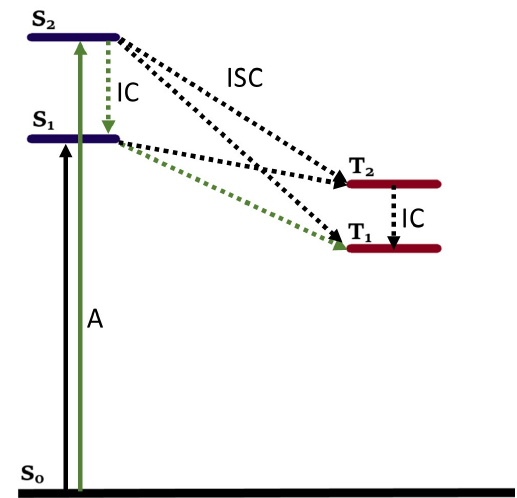
Figure 7. Energy levels involved in triplet generation. The most probable pathway is highlighted in